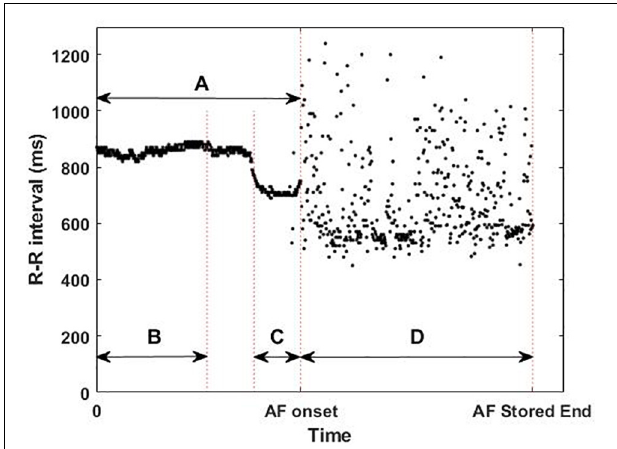
FIGURE 2 | Example of available implantable cardiac monitor data: (A) whole flashback, (B) first 300 beats of the flashback, (C) last 100 beats of the flashback, and (D) first 2 min of the last atrial fibrillation (AF) episode recorded before catheter ablation, illustrating the short-term changes in the R–R intervals (ms) prior to the AF onset and the differences in R–R intervals between the flashback (A) and the AF episode (D) .